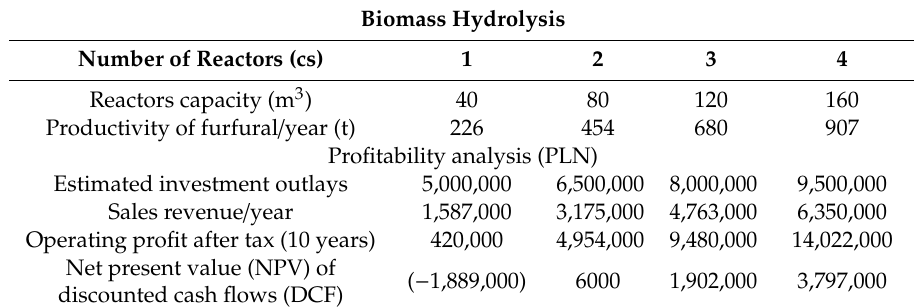
The discounted cash flow method was used to calculate investment projections, assuming a 10% rate of return. The investment period was assumed to be 10 years and the calculations were made for the entire 10-year